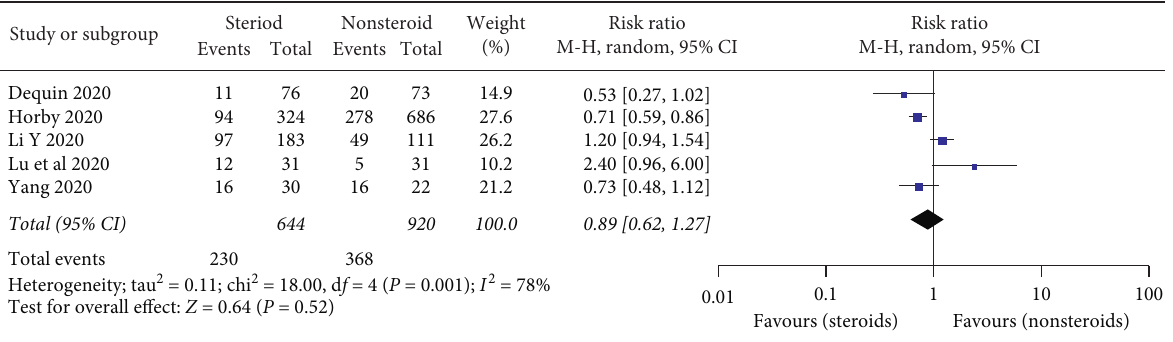
Figure 3: Forest plot for mortality associated with steroid use in patients with critically ill COVID-19